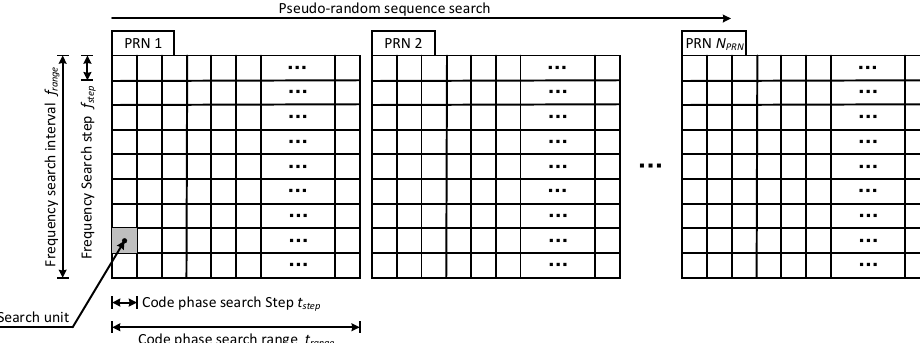
Figure 2. The search process for navigation signal acquisition.